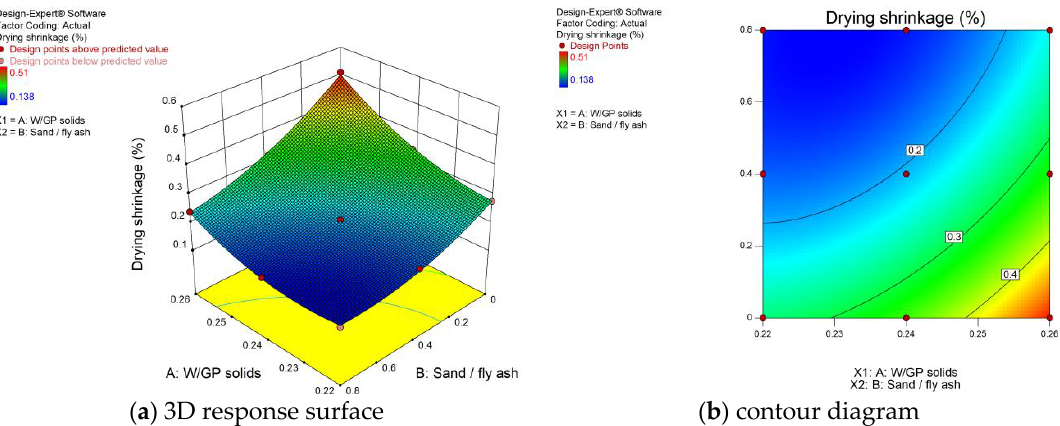
Figure 11. Drying shrinkage versus W/GP solids and sand/fly ash. ( a ) 3D response surface, ( b ) contour diagram.